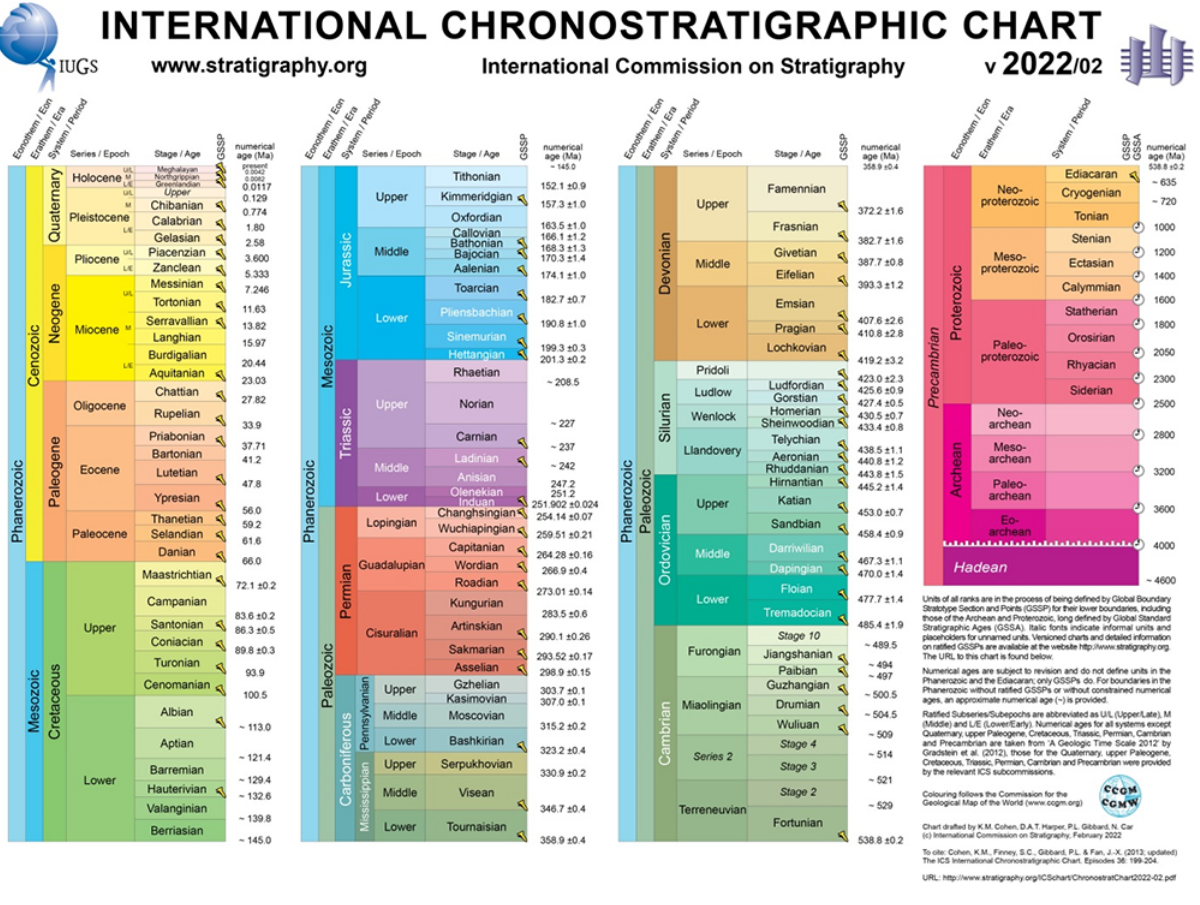
Figure 1 ICS International Chronostratigraphic Chart 2022/02 (Cohen et al., 2022).